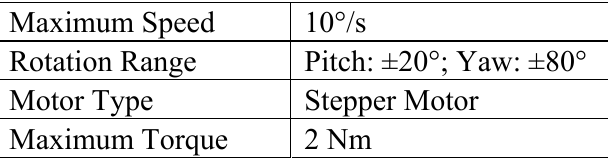
Table 2. Performance of the 2D